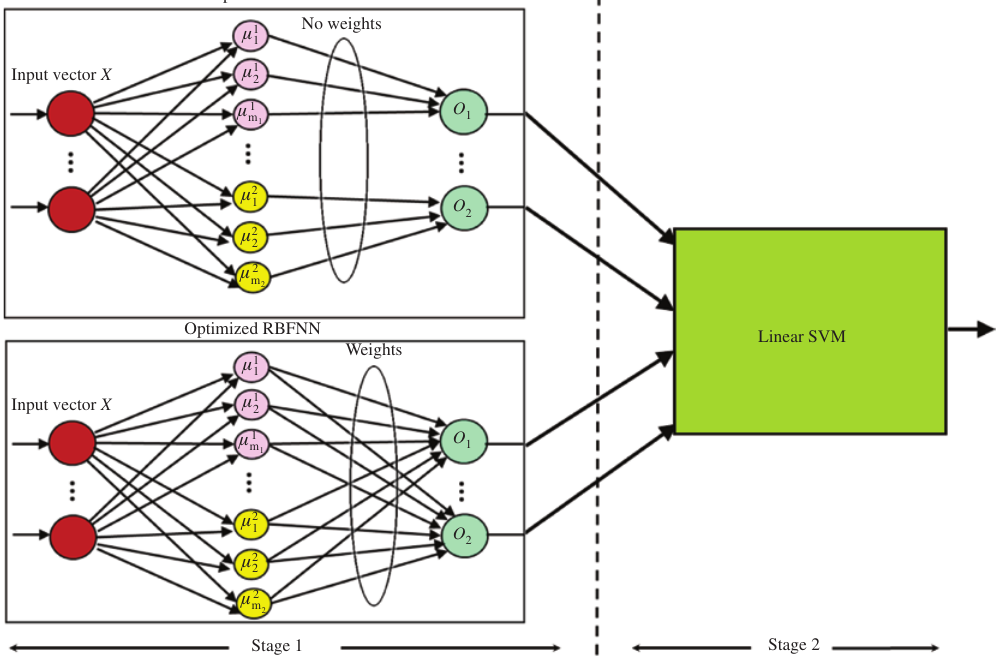
Figure 3: Proposed Dia-Net